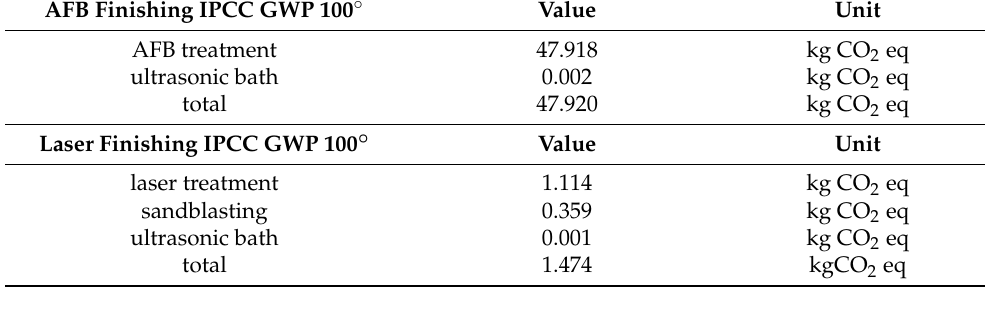
Table 4. Computed values of IPCC GWP 100 ◦ for each analyzed finishing process.